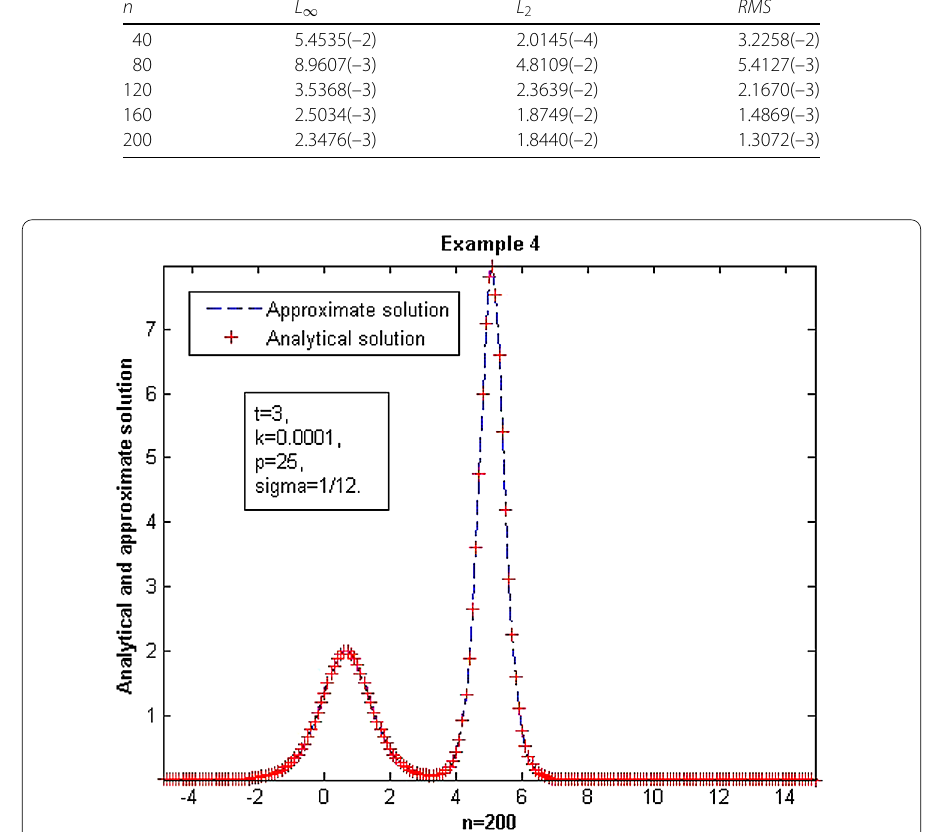
Figure 4 Comparison between analytical and approximate